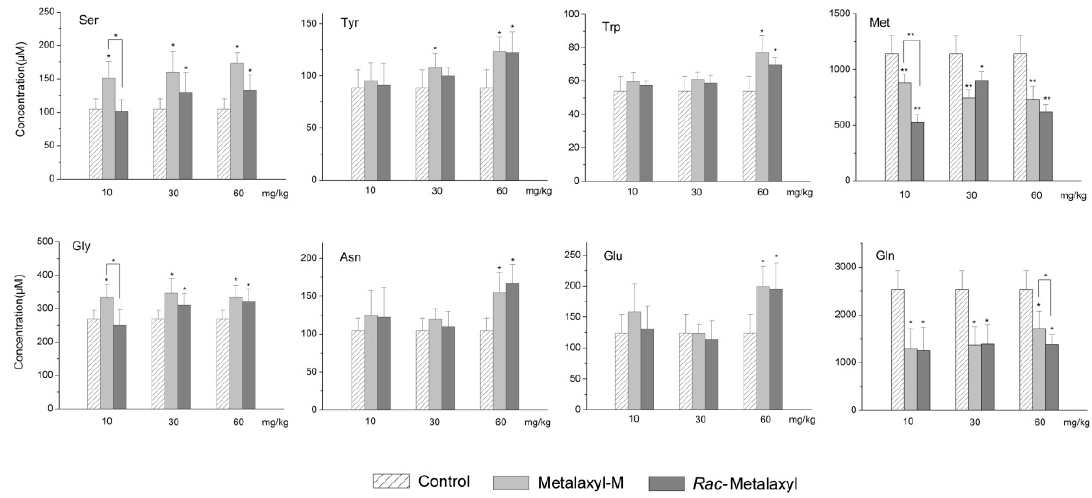
Figure 6. Alterations of serum amino acids induced by rac -metalaxyl and metalaxyl-M. Asterisks indicate significant di ff erences (* p < 0.05 and ** p < 0.01) between treatment and control